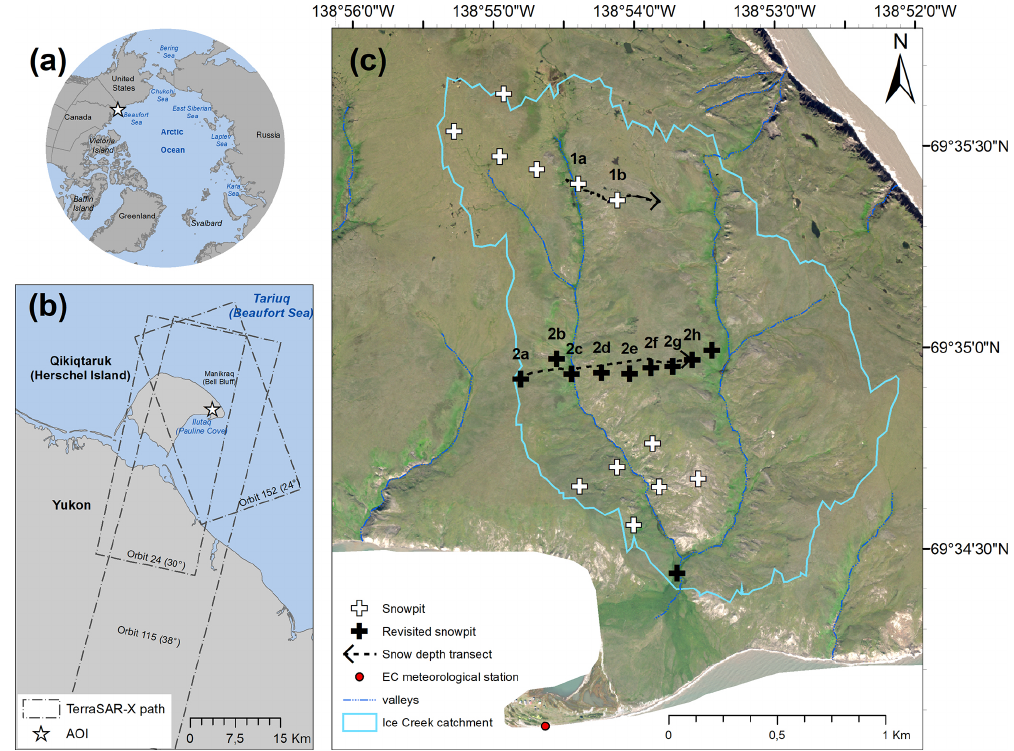
Figure 2. (a) Location of the study site in the arctic. (b) Visual extent of TerraSAR-X passages on Qikiqtaruk/Herschel Island. (c) Ice Creek study site including the location of measurements. The black crosses were revisited during each TerraSAR-X acquisitions (imagery provided by Worldview 01.01.1001, true color). The meteorological station belongs to Environment and Climate Change Canada (ECCC). AOI signifies area of interest. Table 1. In situ measurements during the 2019 field